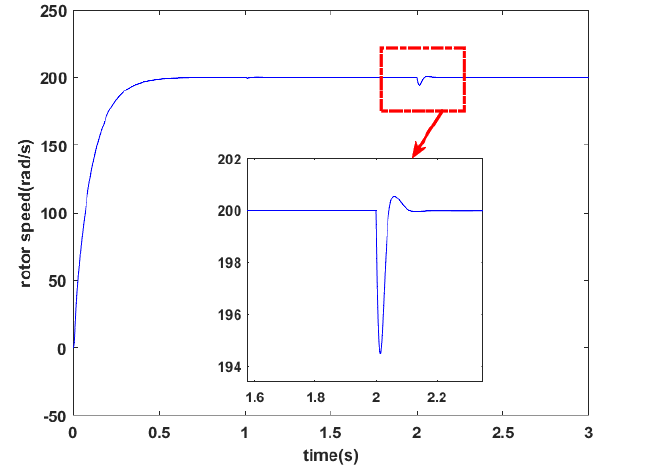
Figure 8. Rotor speed under variation 100% of Rr.